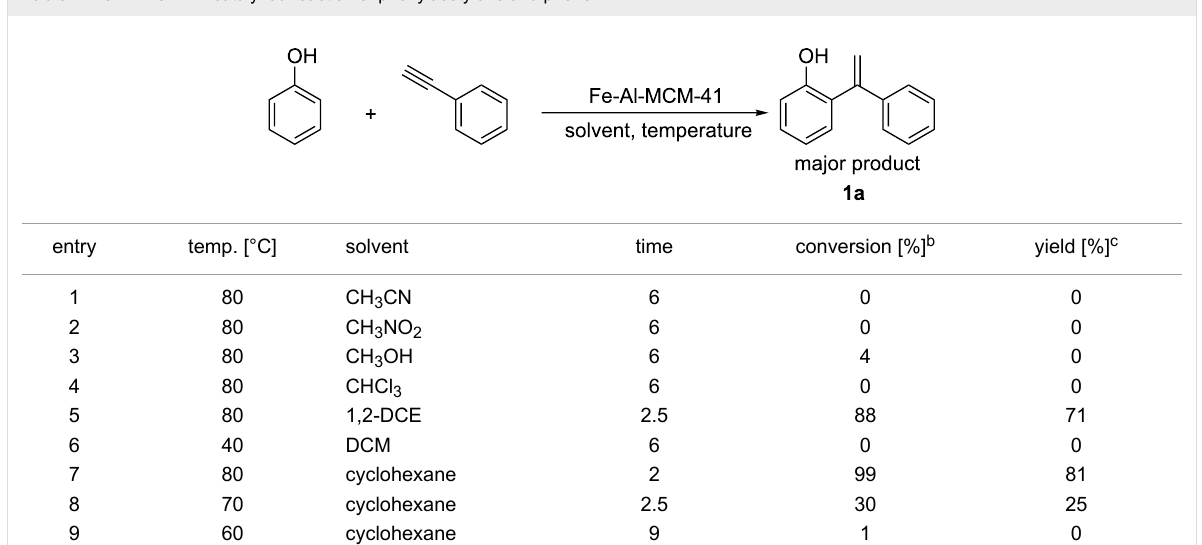
Table 1: Fe-Al-MCM-41-catalyzed reaction of phenylacetylene and phenol a .